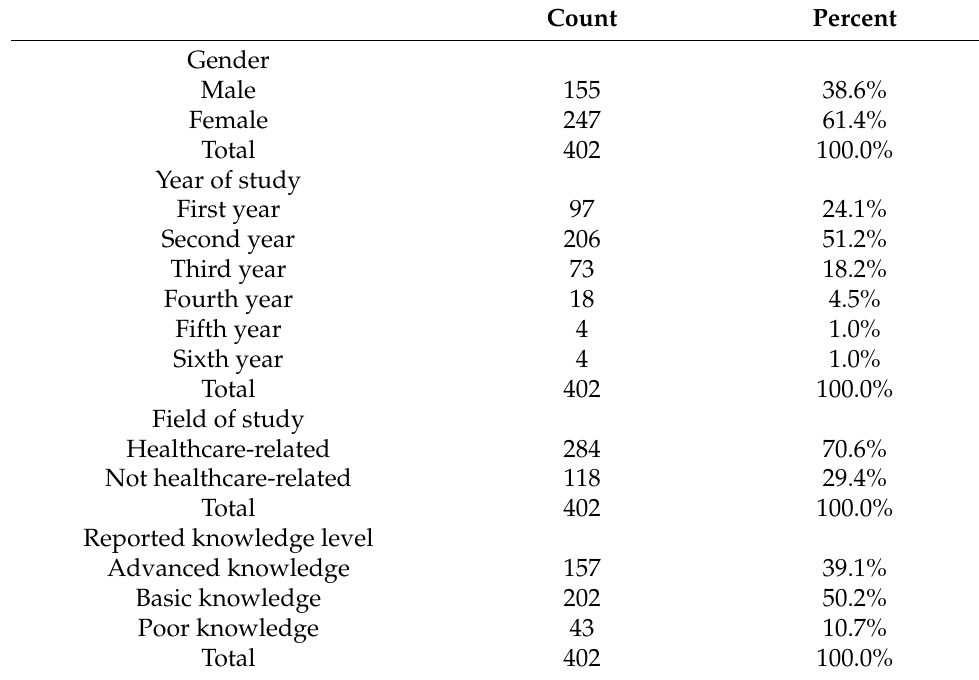
Table 1. Demographics and general characteristics of participants.